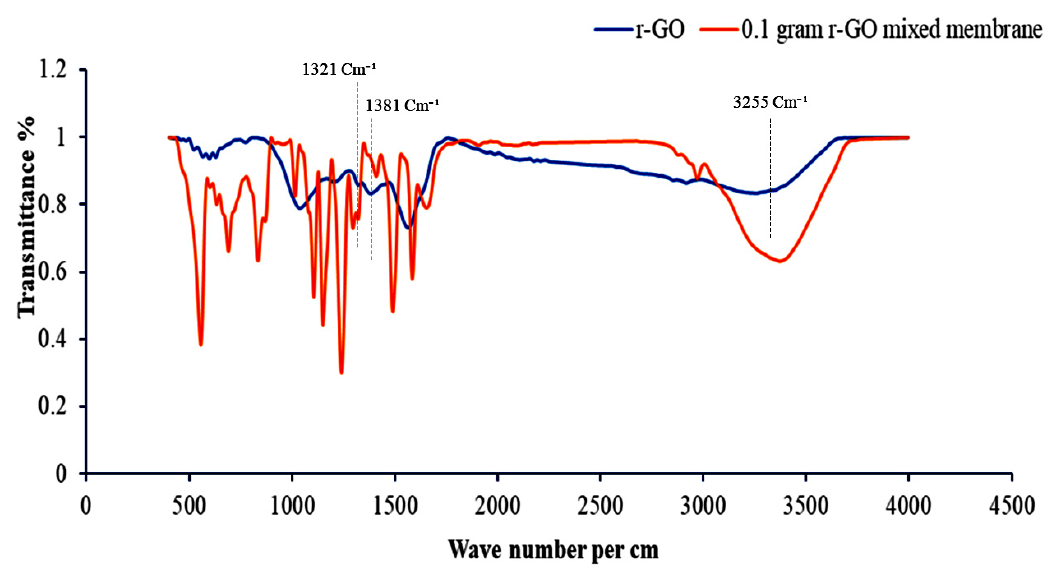
Figure 11. FTIR analysis of r-GO nanomaterials and sample C membrane before filtration.